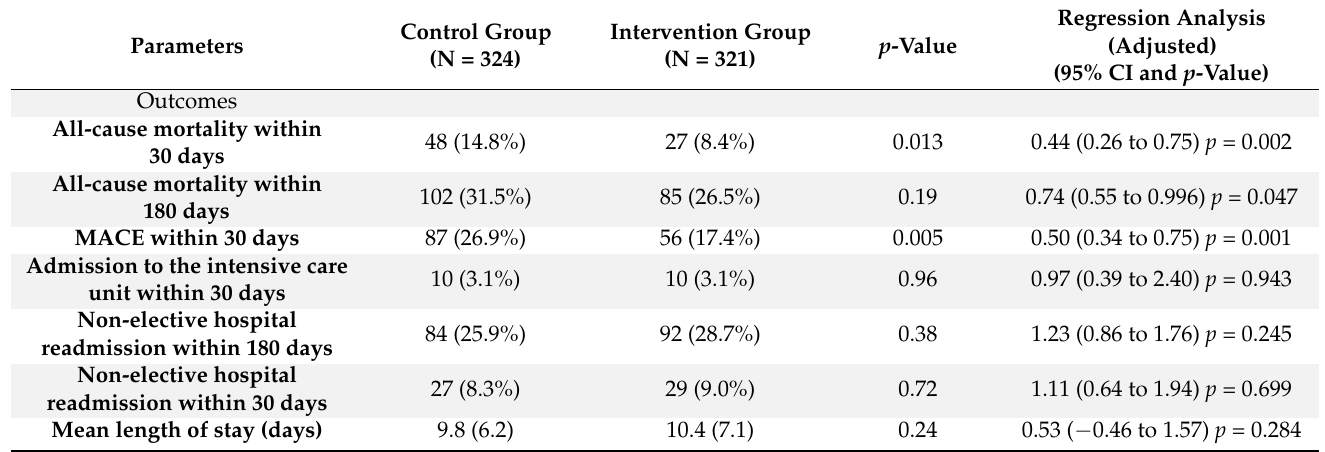
Table A3. Clinical outcomes in patients randomized to the intervention and the control group according to the original